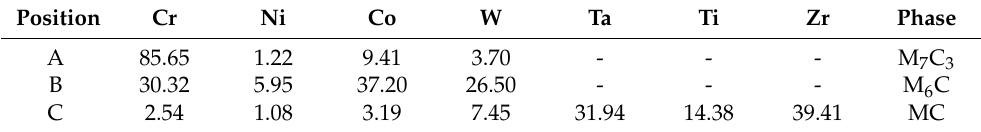
Table 2. EDS chemical analysis (at.%) of different positions in Figure 2.